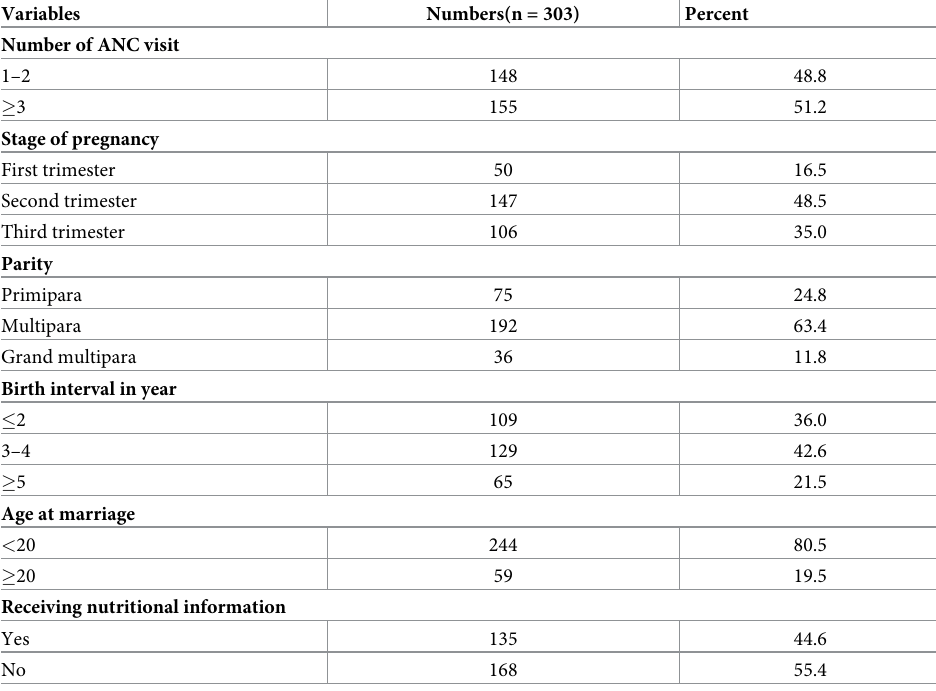
Table 2. Obstetrics characteristics of study participants in Wachemo University Nigist Eleni Mohammed Memo- rial referral hospital, 2019.